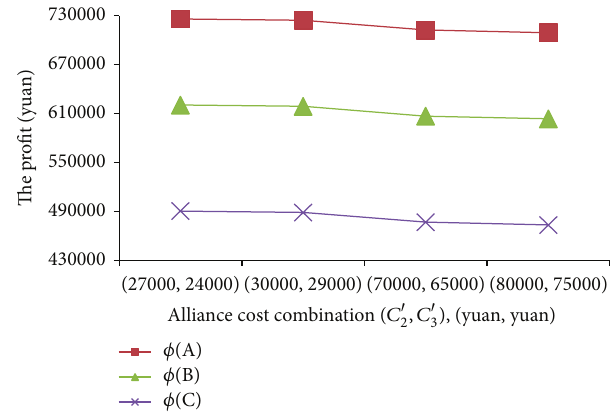
Figure 2: The influence of different alliance cost combinations on the profit